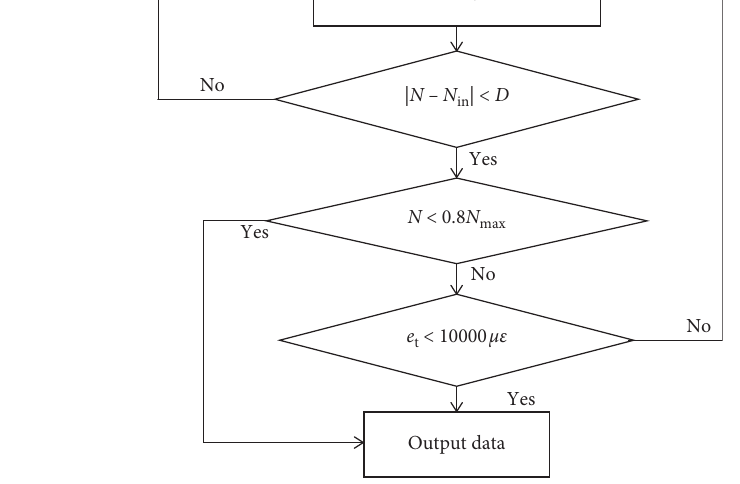
Figure 10: The algorithm of calculation.